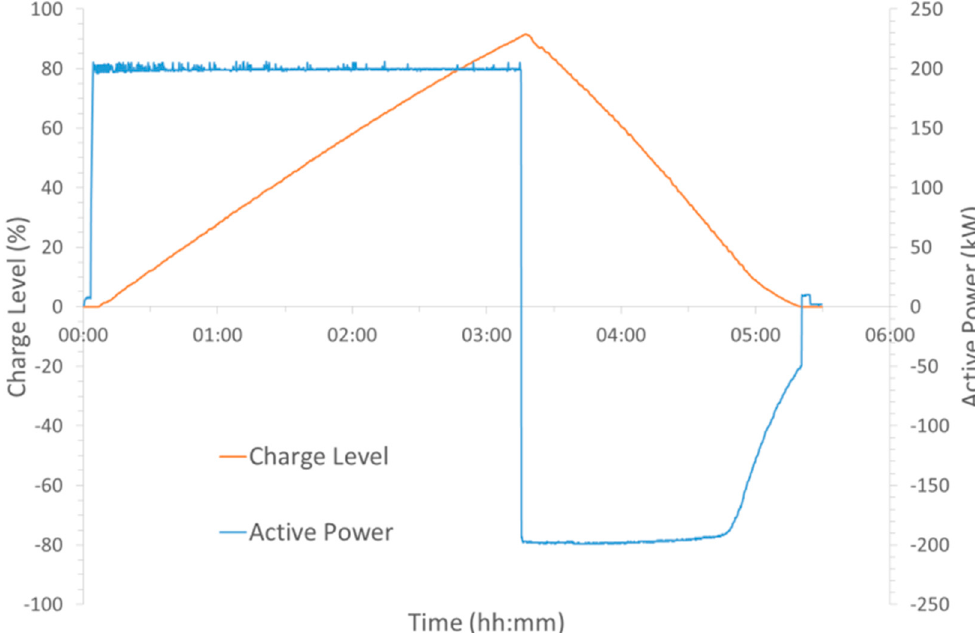
Figure 3. Active power and charge level for a charge and discharge cycle at 200 kW.